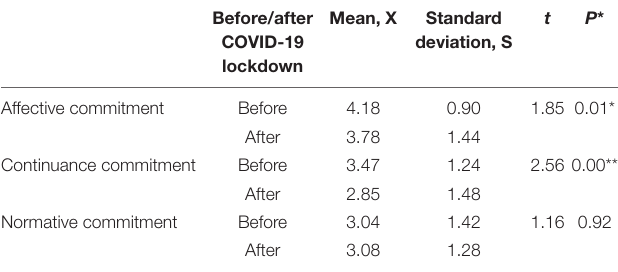
TABLE 2 | Subcomponent commitment levels of teachers (after Meyer et al., 1993). Before/after